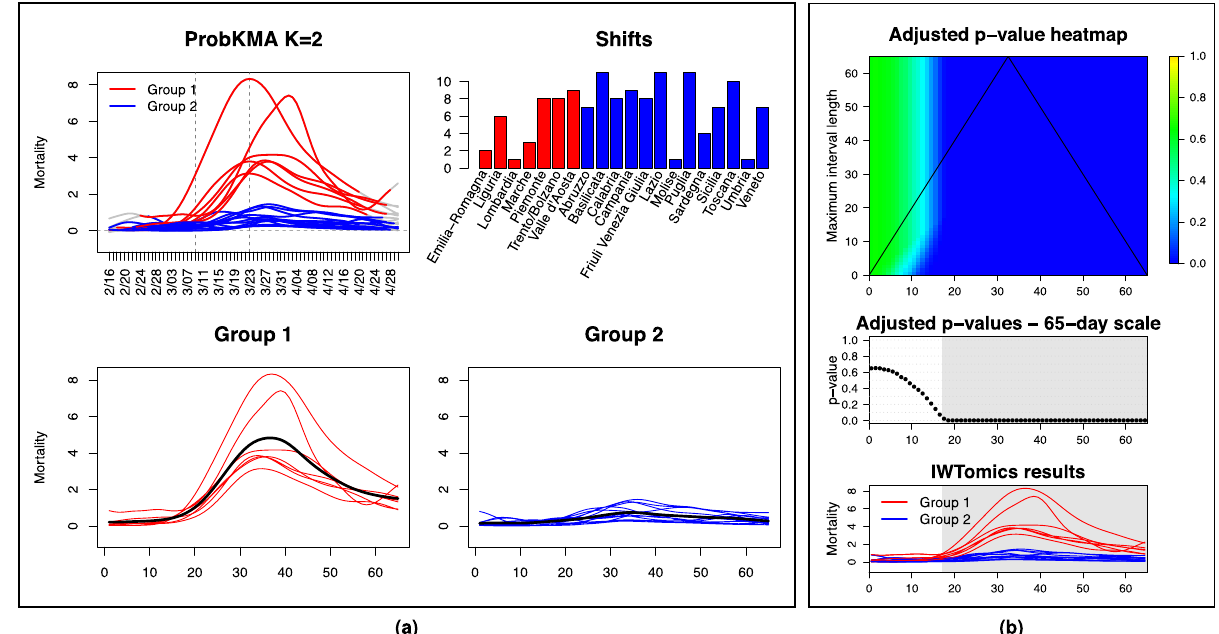
Figure 2. Characterizing two epidemics. ( a ) MAX mortality curves are shown in the top left panel with 65-day portions identified by probKMA with K = 2 in red (Group 1; “exponential” pattern) and blue (Group 2; “flat(tened)” pattern). The curve portions are shown again, this time aligned with each other and separated by group, in the bottom panels. Black lines indicate group averages. The shifts produced by probKMA are shown in the top right panel (motifs, groups and shifts for Group 1 are stable across data sets; shifts for Group 2 are less stable and less interpretable—see Fig. S3). ( b ) Shifted Group 1 and Group 2 MAX mortality curves are tested against each other with IWTomics . The heatmap at the top shows p -values adjusted at all possible scales (from 1 to 65 days). The middle panel shows in detail the top-most row of the heatmap; i.e. the p -values adjusted across the whole 65-day interval. The bottom panel shows again the shifted curves. Gray areas in the middle and bottom panels mark days when the difference between the two groups has an adjusted p -value ≤ 5% (see Table S1). Starting a little over two weeks from the beginning of their epidemic, curves in the two groups differ at all temporal scales with adjusted p -values ≤ 5%